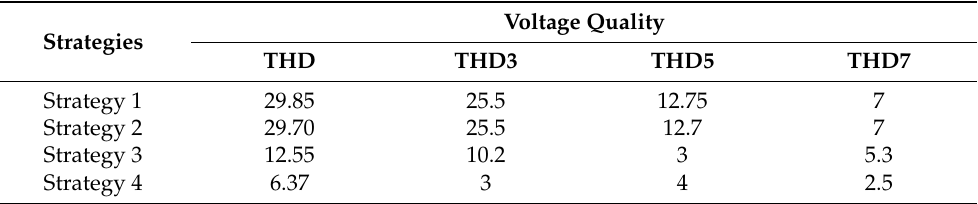
Table 2. Comparison of voltage quality in terms of harmonics in the first scenario.